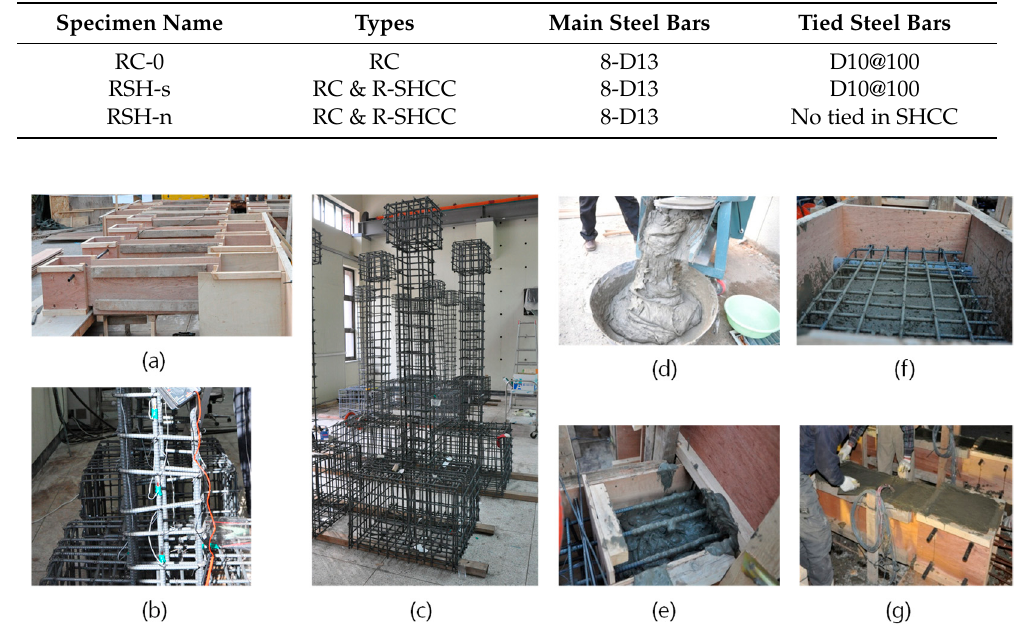
Table 1. Experimental variables of three column specimens.